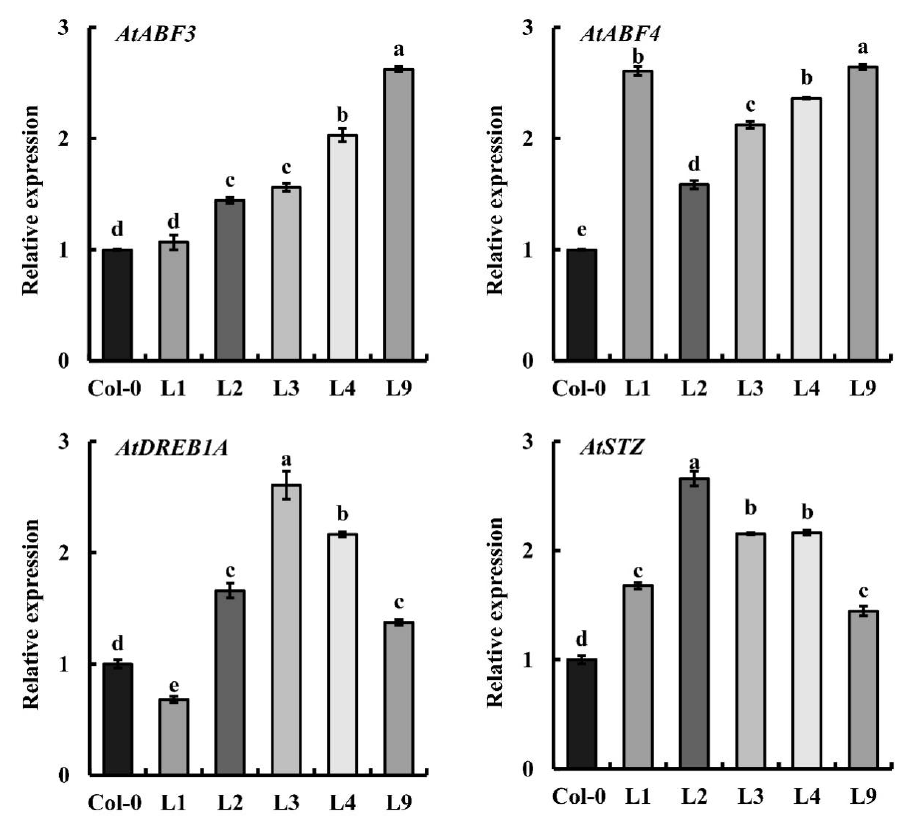
Figure 5. The genes regulated by GhGT26 to characterize the effects of this heterologous expression. The expression of the gene in the Col-0 was used as the control. Vertical bars indicate the ±SD of three technical replicates of the pooled treated samples. The different letters above the columns indicate significant differences ( p < 0.05) based on the EM-based Student t test performed using GraphPad Prism 8.0.